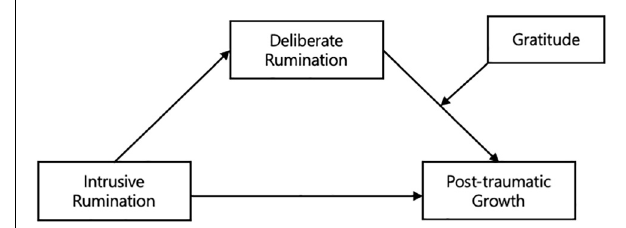
FIGURE 1 | Hypothetical Model.